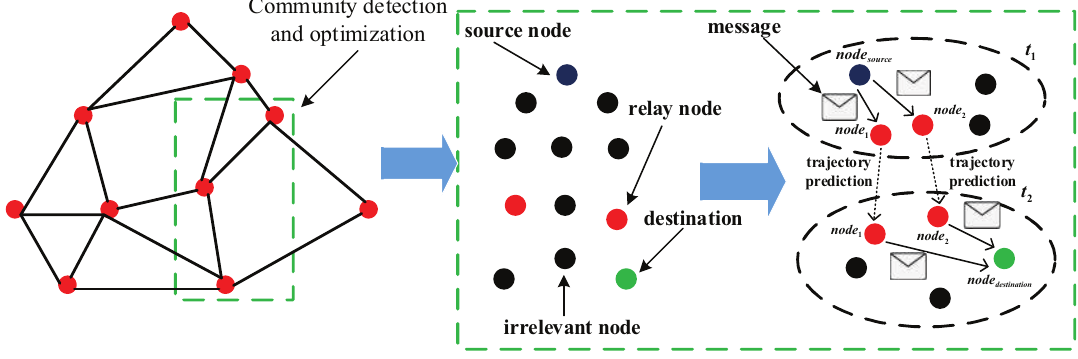
Figure 3. Message routing and forwarding based on location prediction and community optimization.